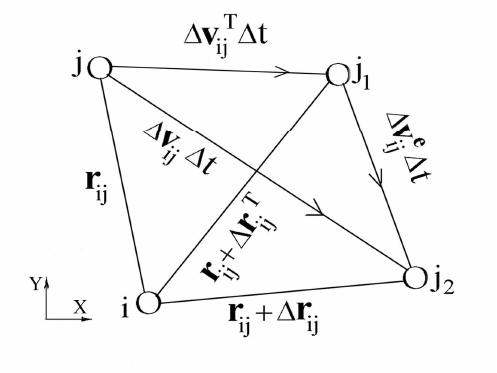
Figure 1 . Distance between particles i and j at moment t and t + ∆ t